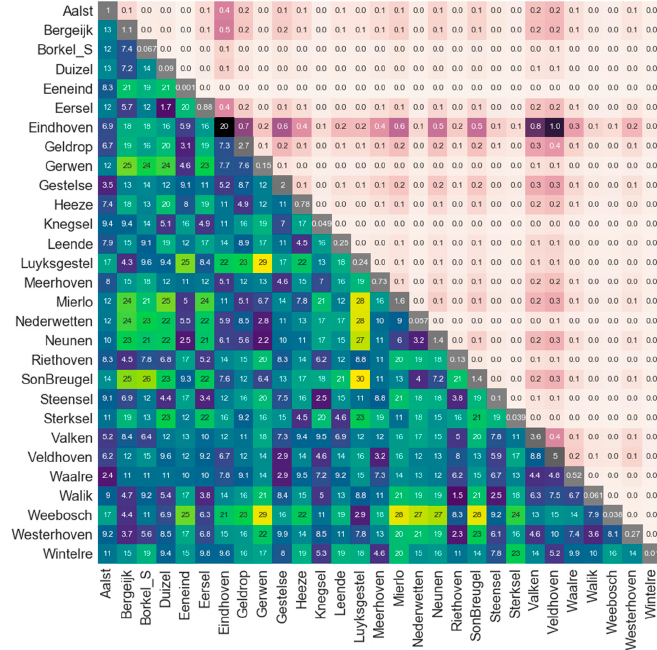
Figure 4. Length scales for each municipal urban drainage system. Distance between area centroids (km) is shown in the lower triangular. The diagonal displays the area size (km 2 ). The upper triangular shows a ranking of the relative importance between areas.